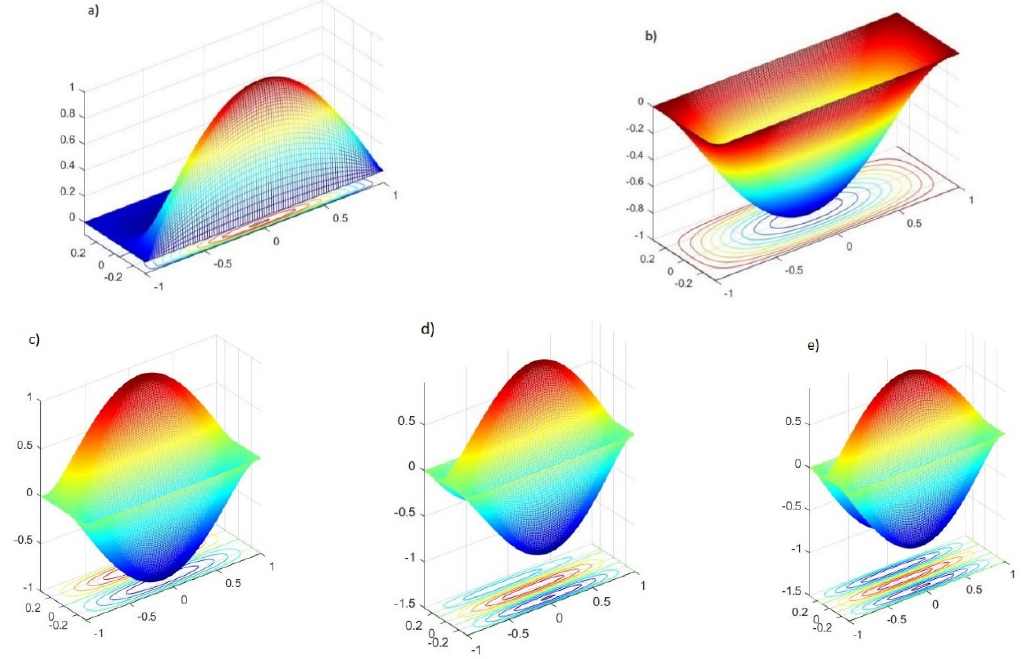
Figure 17. Vibrational modes for the USFG distribution with η = 1 and µ = 0.5: ( a ) 1st mode, ( b ) 2nd mode, ( c ) 3rd mode, ( d ) 4th mode, ( e ) 5th mode.